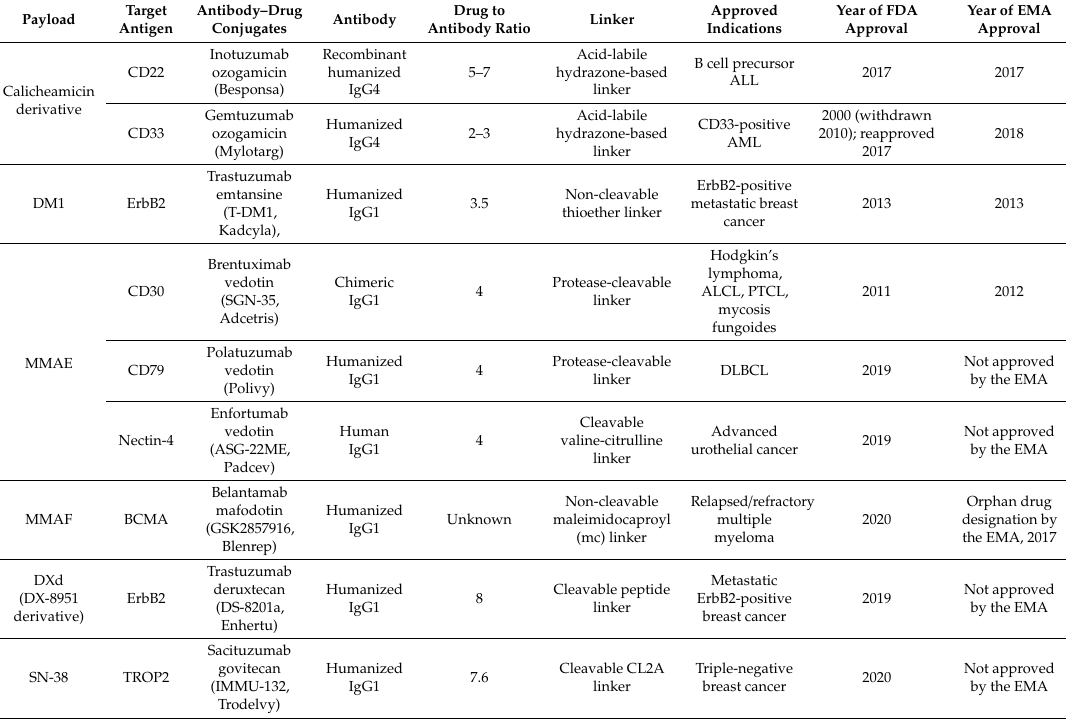
Table 2. Antibody–drug conjugates approved by the FDA for clinical